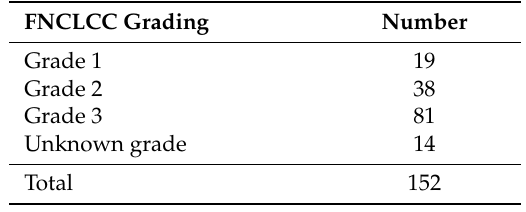
Table 3. F é d é ration Nationale des Centers de Lutte Contre le Cancer grading of the sarcomas.